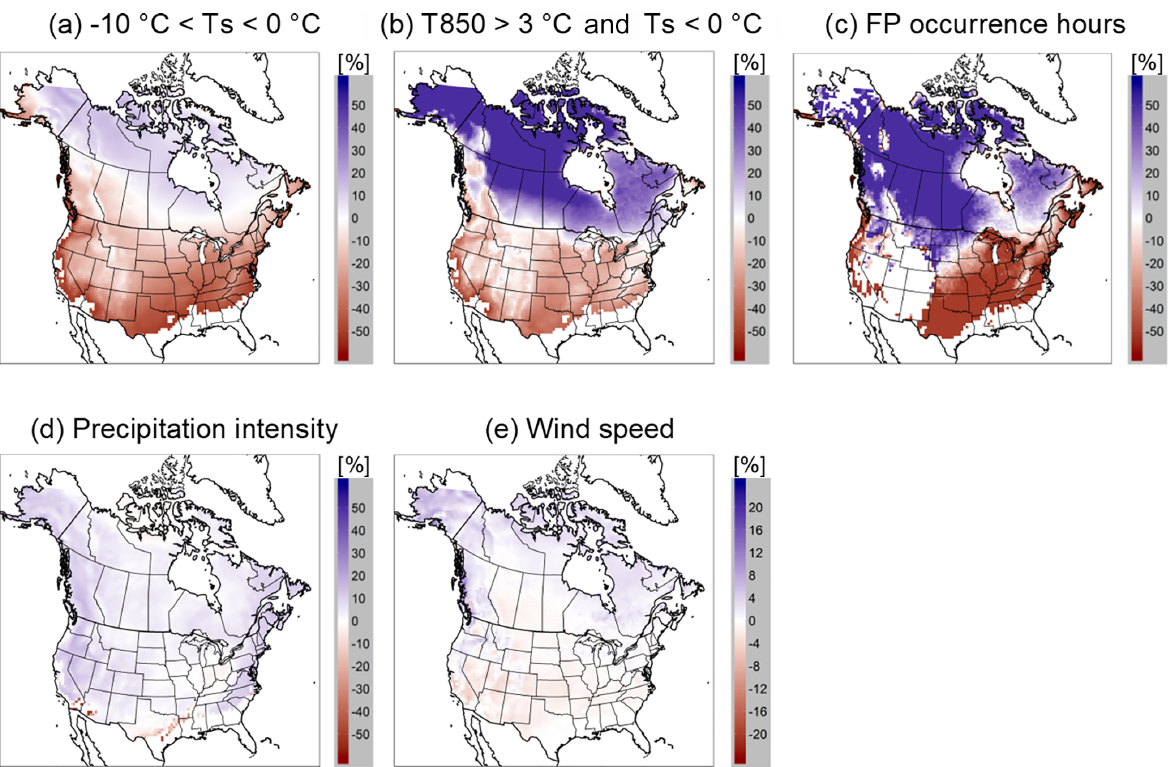
Figure 7. Projected changes to frequencies of (a) surface temperature (Ts) condition (i.e., − 10 ◦ C<Ts<0 ◦ C) and (b) combined Ts and temperature at 850hPa (T850) condition (i.e., T850>3 ◦ C and Ts<0 ◦ C), representing favourable temperature conditions for FP occurrence and (c) freezing-precipitation (FP) occurrence hours from the CanRCM4 large ensemble at + 2 ◦ C GMTC level with respect to the baseline period. Projected changes to precipitation intensity and surface wind speed from the ensemble at the same GMTC level are presented in (d) and (e) . All values are calculated for the freezing season (i.e., from onset to offset of Ts<0 ◦ C) for each